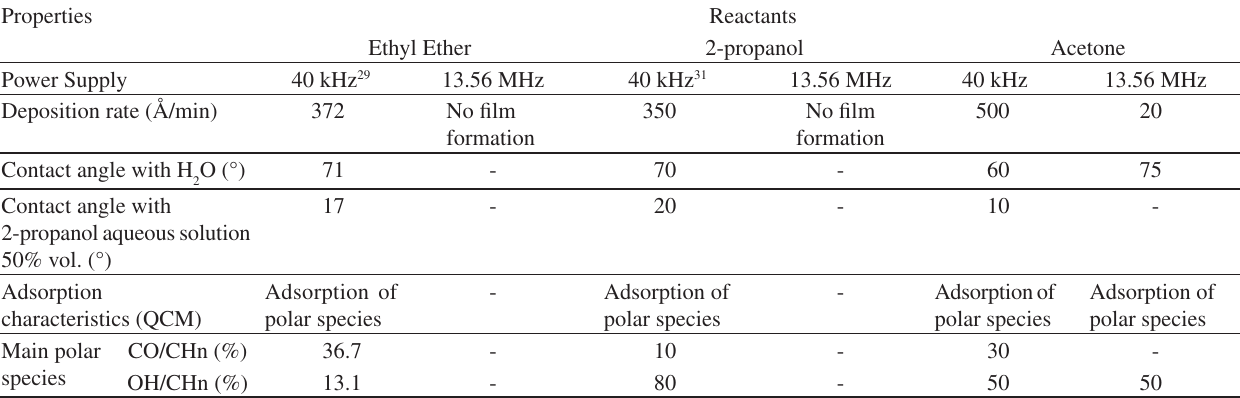
Table 2. Deposition conditions and most important characteristics obtained for plasma deposition of ethyl ether, 2-propanol and acetone on silicon substrates using planar reactor powered with 40 KHz or 13.56 MHz.